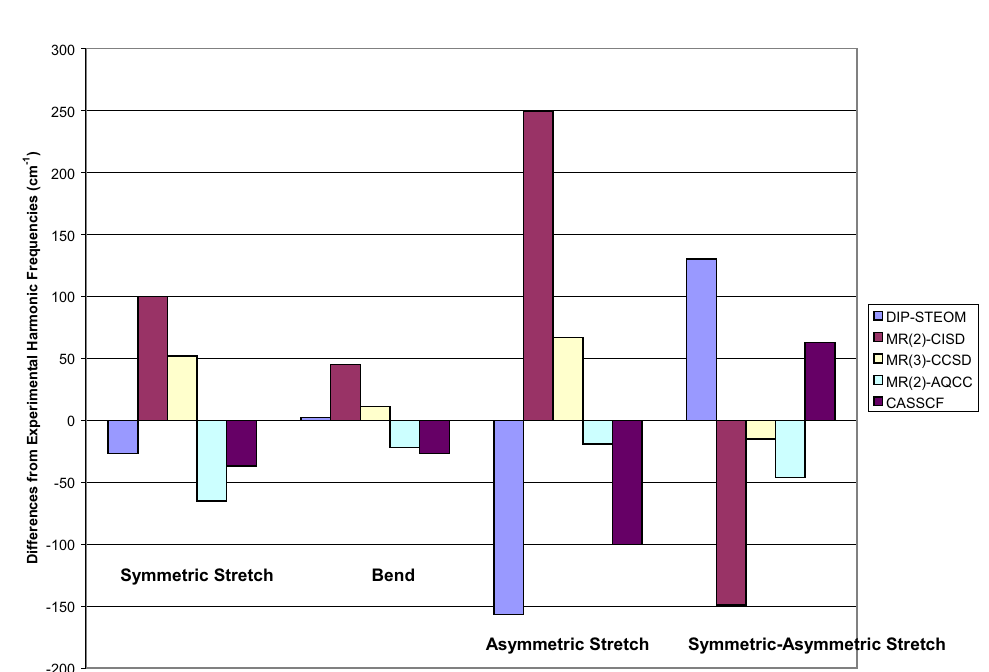
Figure 5: Vibrational frequencies of ozone for various multi-reference methods within a DZP